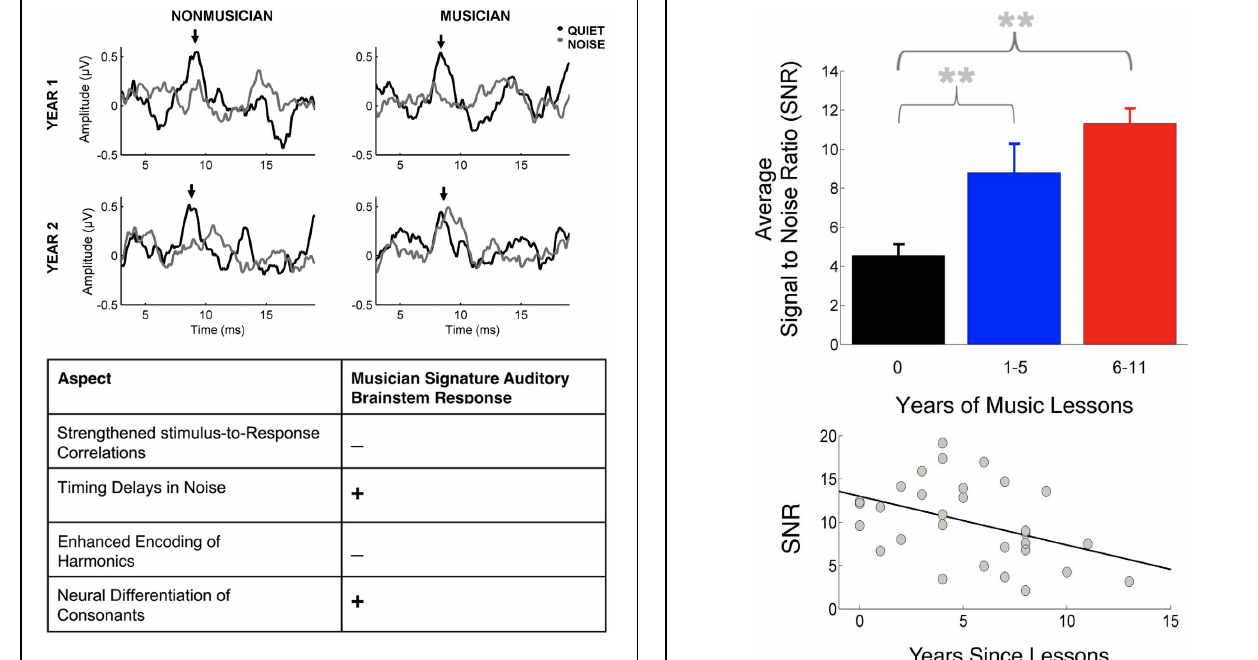
2012; see also White-Schwoch et al., in press), consistent with ani-